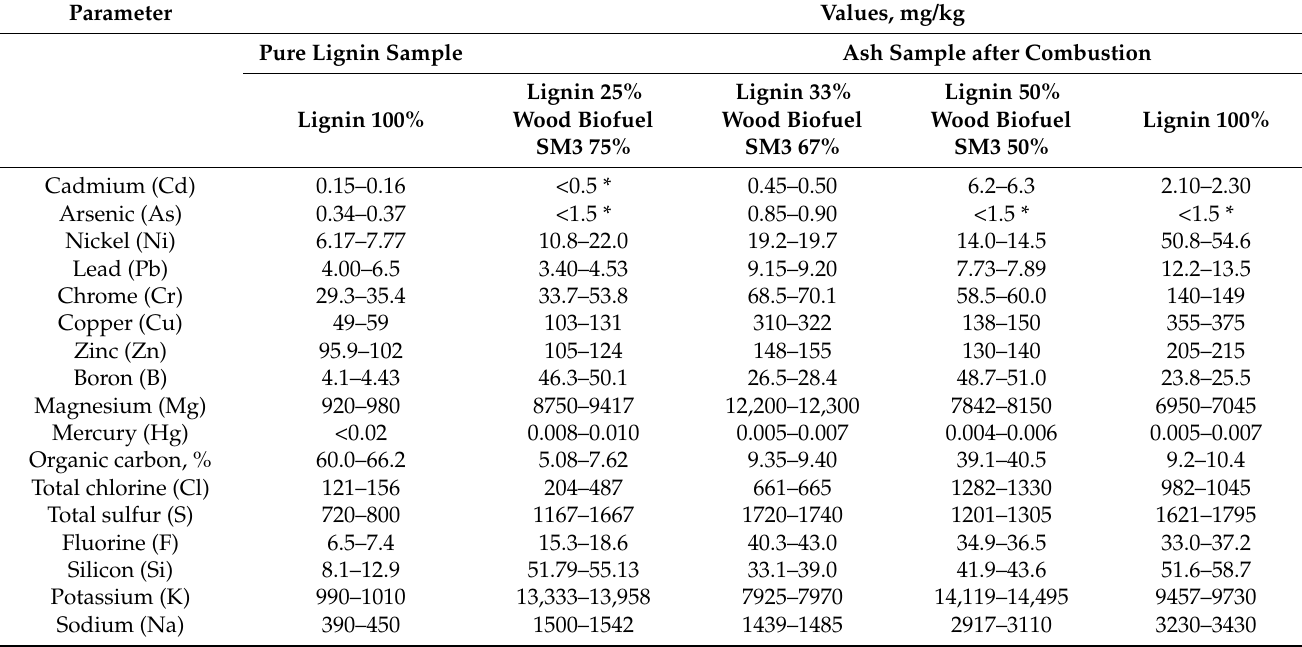
Table 4. The composition of bottom ash using the biofuel mixture produced from lignin (33%) and SM3 biofuel (67%) in boiler